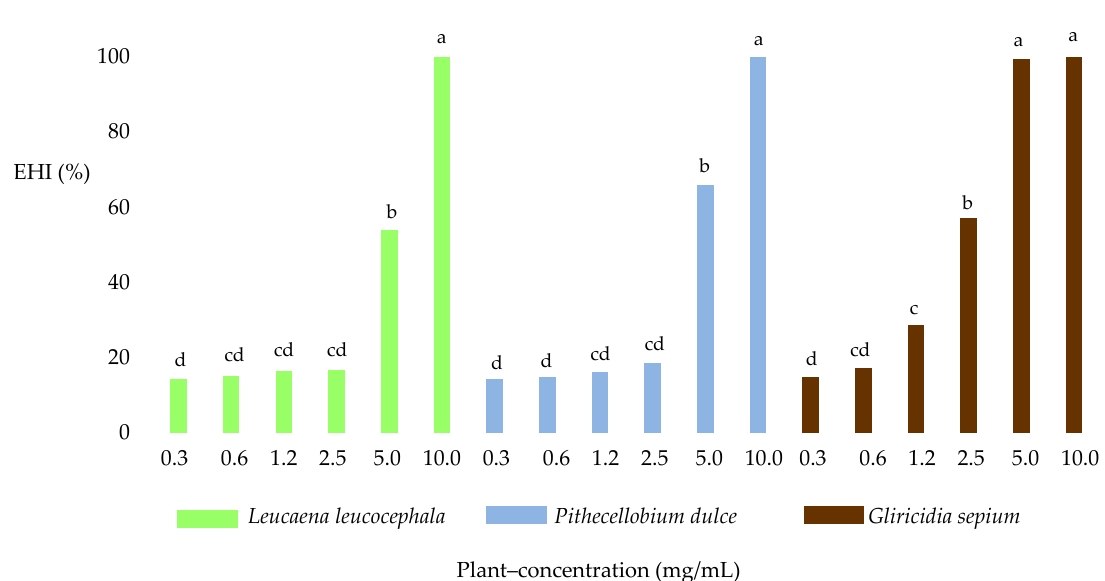
Figure 2. Effect of plant–concentration on the percentage of egg hatch inhibition (EHI). Means marked with the same letter are not significantly different ( p > 0.05). Fisher LSD test.